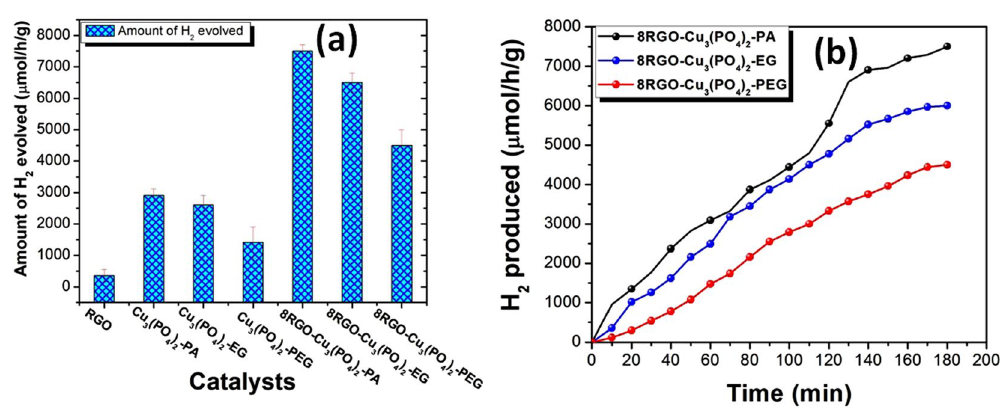
Figure 12. Proton reduction potential of ( a ) all the catalysts ( b ) the catalysts 8RGO-Cu 3 (PO 4 ) 2 -PA/EG/PEG with respect to 180 min of time under visible light illumination.